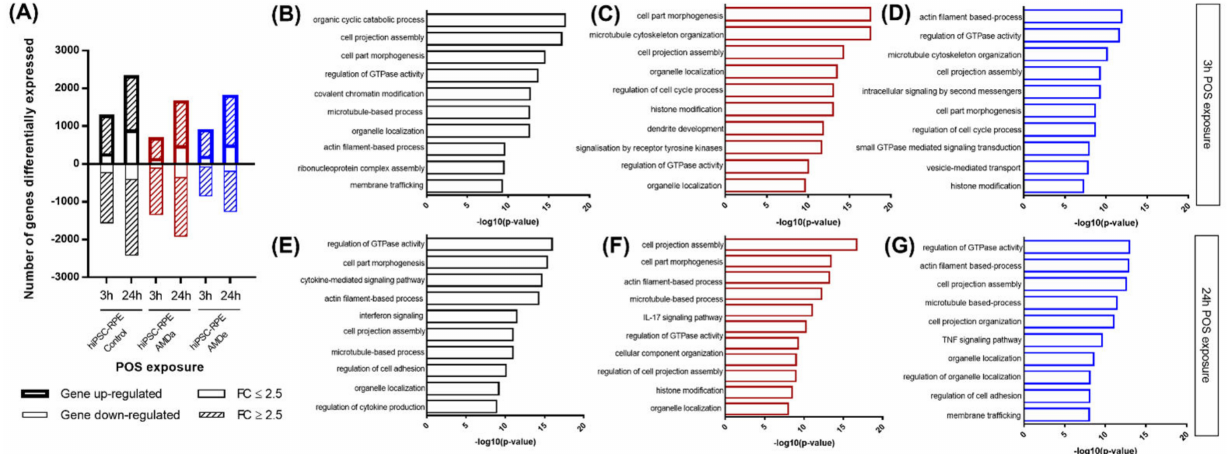
Figure 4. RNA seq analysis of both hiPSC RPE Control and AMD cells after 3 h and 24 h POS exposure. Number of differentially expressed genes in hiPSC-RPE Control (N = 6) AMDa (N = 6) and AMDe cells (N = 3) in basal condition, and after 3 h and 24 h POS exposure ( A ). The Gene Ontology (GO) analyses of highly or lowly (2.5 ≥ FC ≥ 2.5) expressed in hiPSC-RPE Control ( B , E ) AMDa ( C , F ) and AMDe cells ( D , G ) after 3 h ( B , C , D ) and 24 h ( E , F , G ) POS